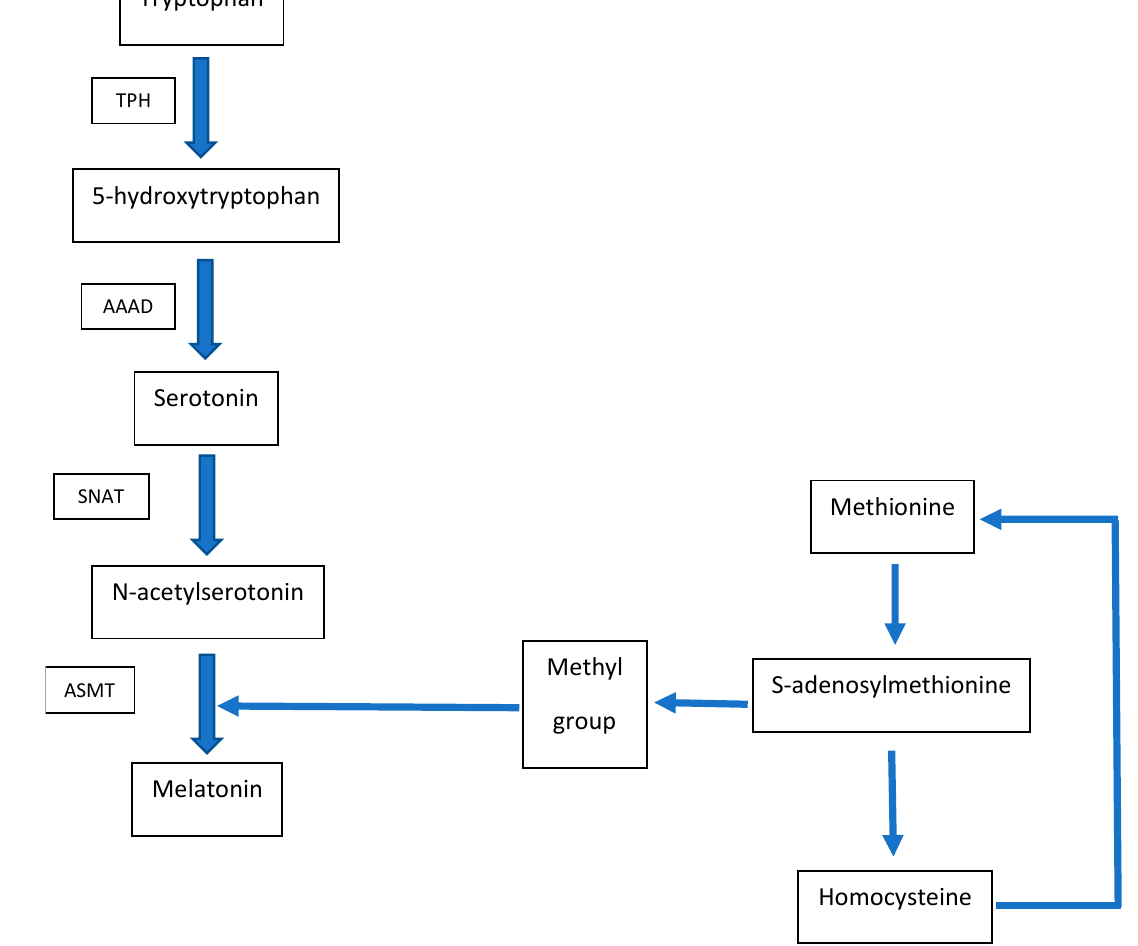
Figure 1. Biochemical interconnection between homocysteine and melatonin metabolism. TPH, tryptophan hydroxylase; AAAD, aromatic amino acid decarboxylase; SNAT, serotonin N -acetyltransferase; ASMT, N -acetylserotonin O -methyltransferase.